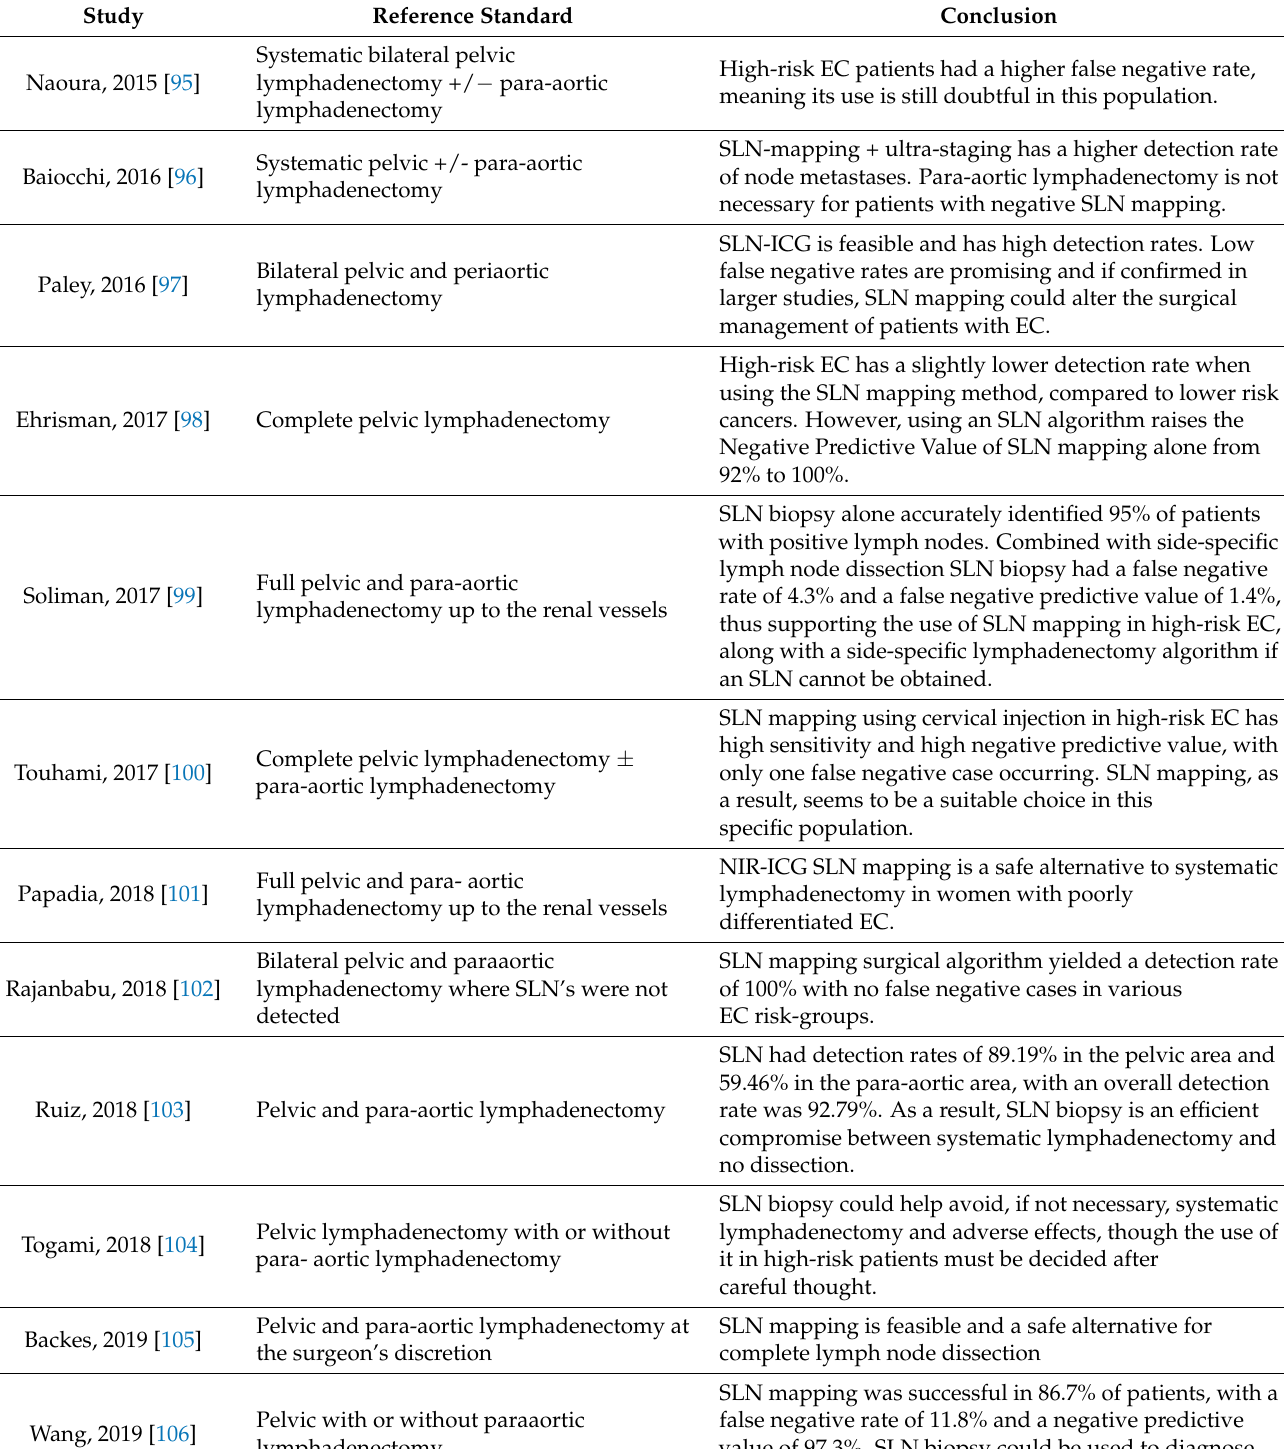
Table 2. Studies involving the role of SLNB in high-risk EC and their